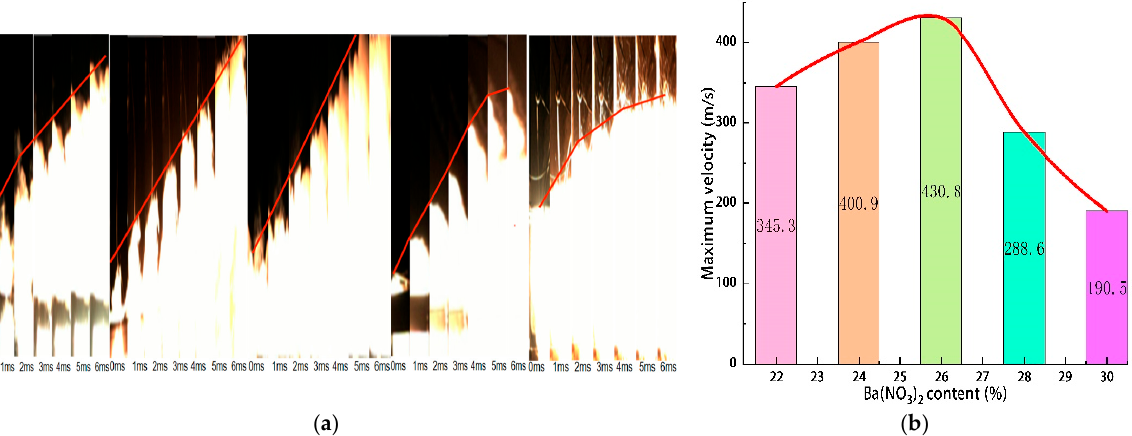
Figure 7. Displacement and velocity changes of heat flow at the axis of the eruption device with different Ba(NO 3 ) 2 content. ( a ) Displacement of heat flow, ( b ) Velocity changes of heat flow.